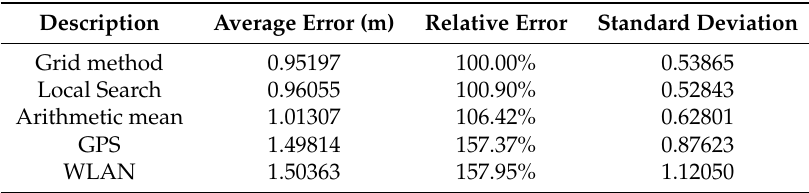
Table 3. Accuracy of GPS and WLAN aggregation (without BLE beacon